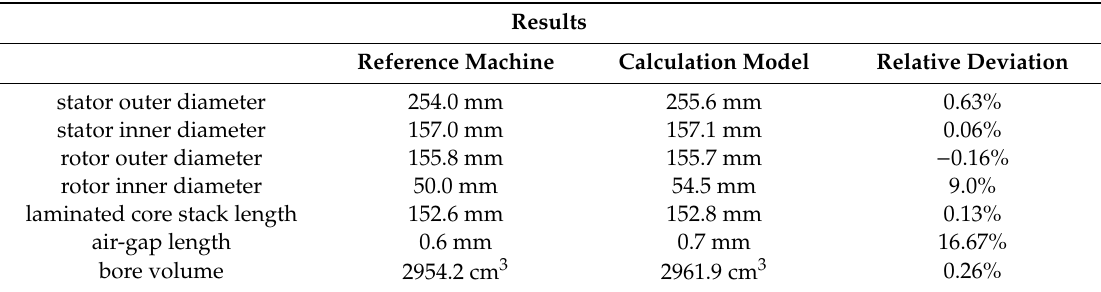
Table 6. Input parameters for validation of main dimensions—Tesla Model